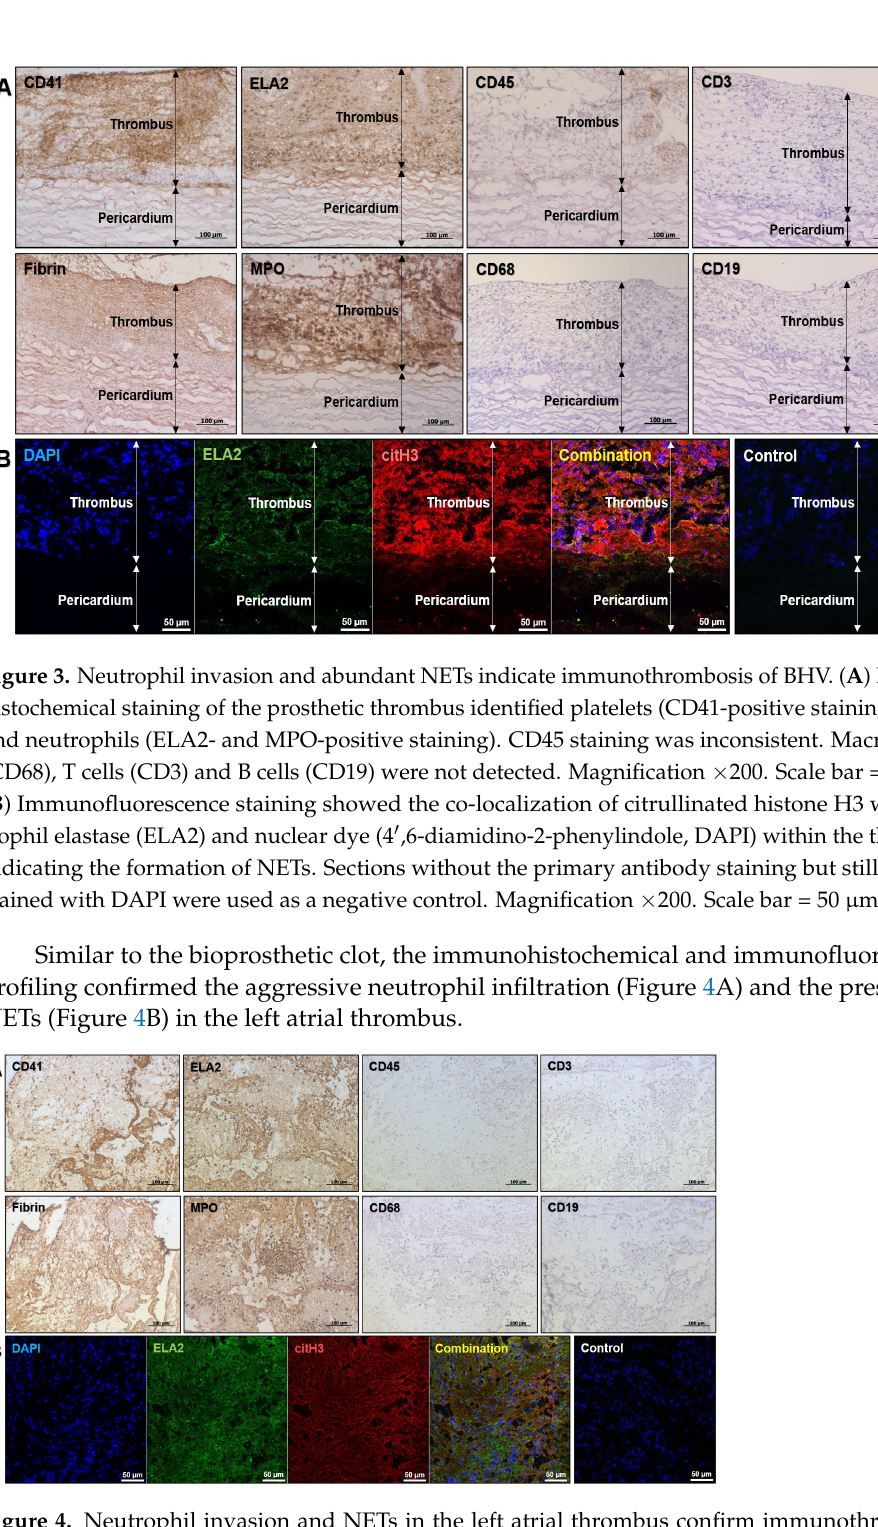
Figure 4. Neutrophil invasion and NETs in the left atrial thrombus confirm